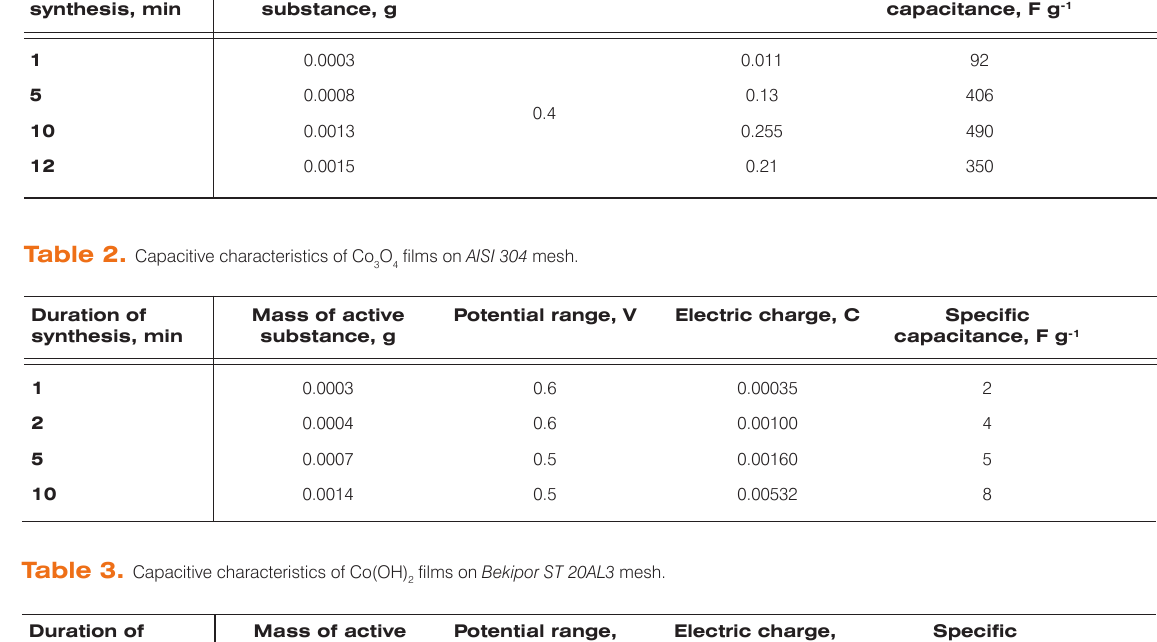
Table 1. Capacitive characteristics of Co(OH)